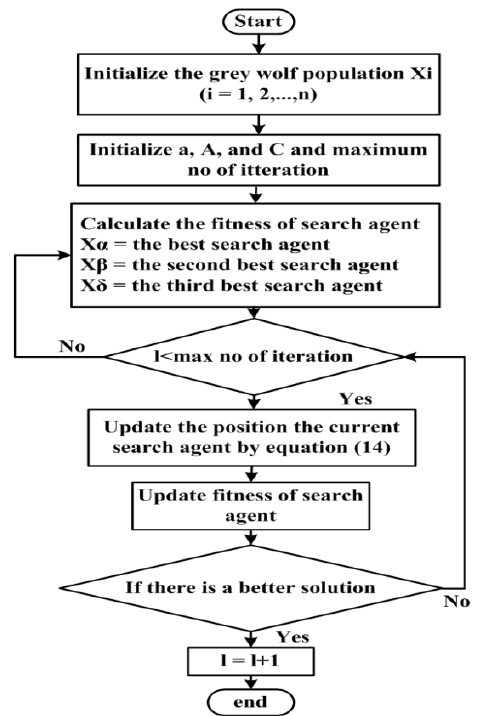
Figure 3. (b) Flowchart of grey wolf optimization